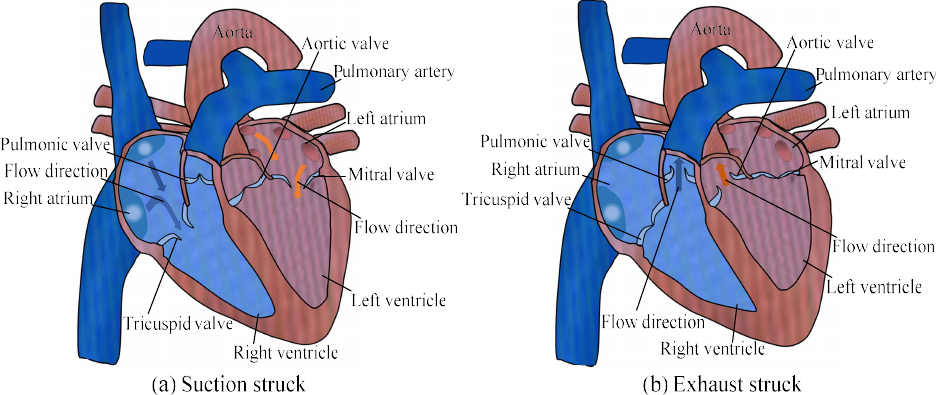
Figure 1. Diagram of working principle of cardiac valves: ( a ) suction stroke and ( b ) exhaust stroke.